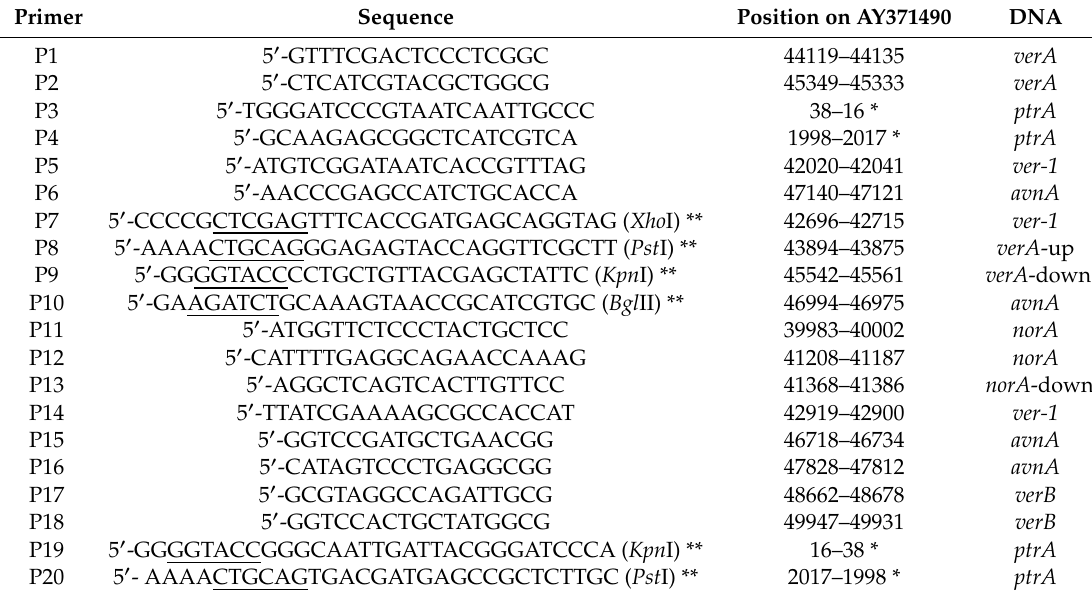
Table 1. Primers used in this